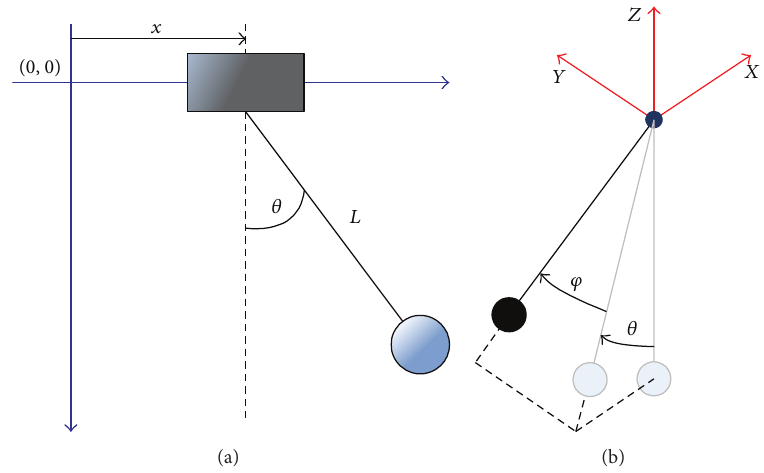
Figure 1: (a) Simple pendulum and (b) spherical